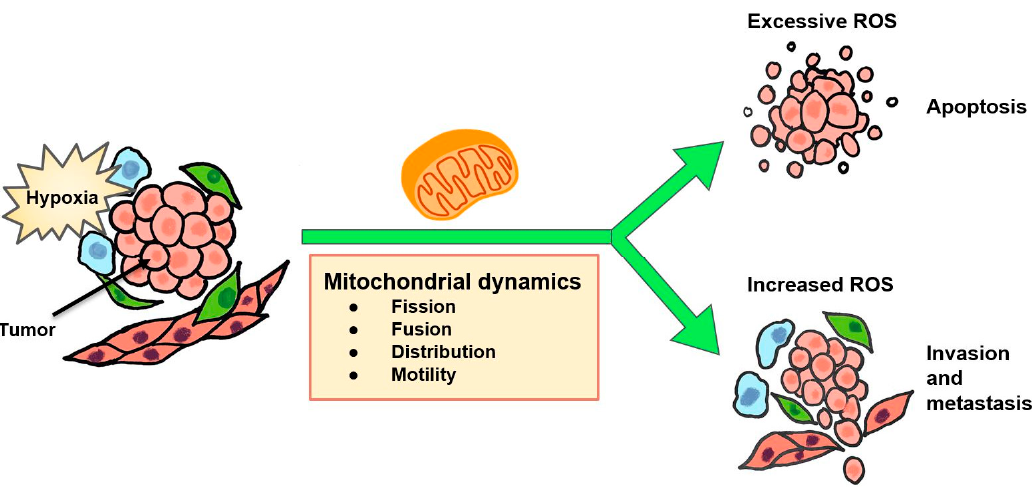
Figure 4. Mitochondrial dynamics may underlie redox homeostasis and the cellular response to hypoxia.